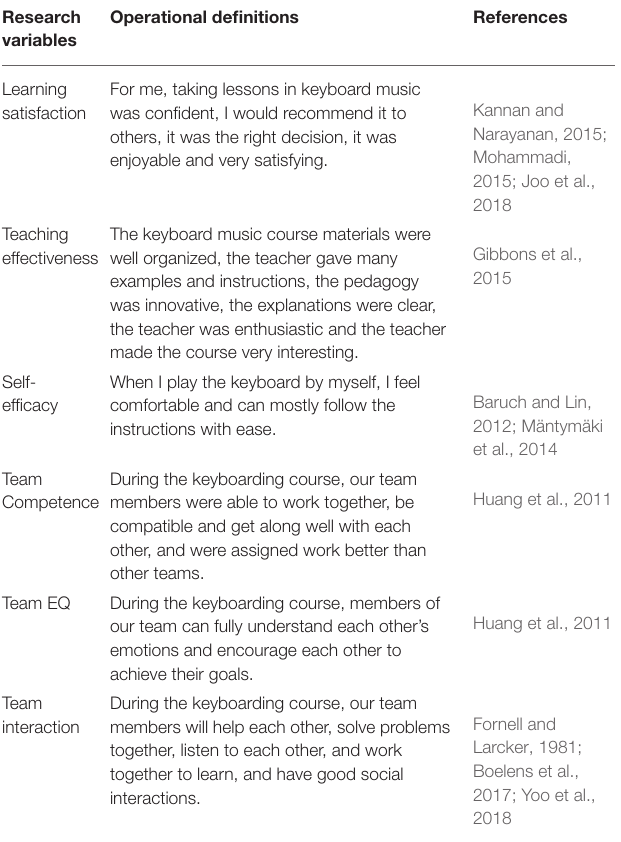
TABLE 1 | Operational definitions of research variables.